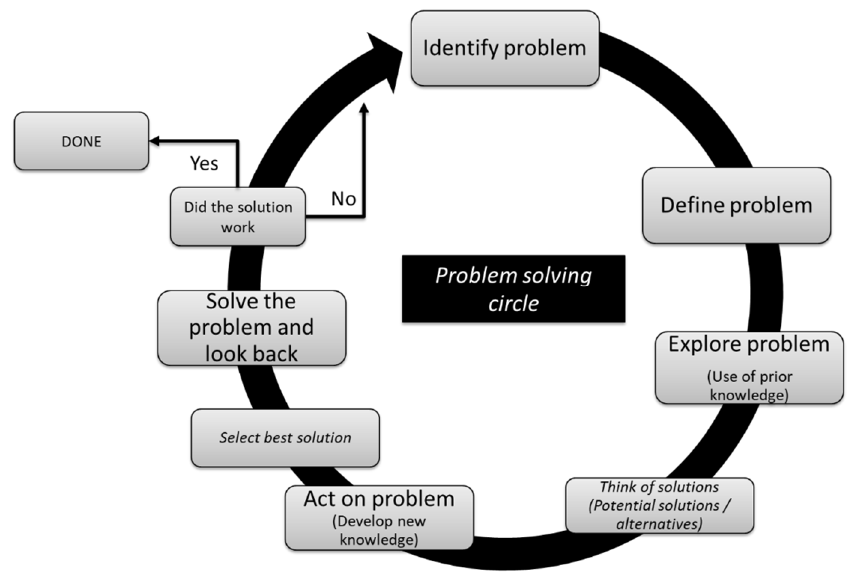
Figure 1. Problem-solving circle related to a veterinary medical problem.